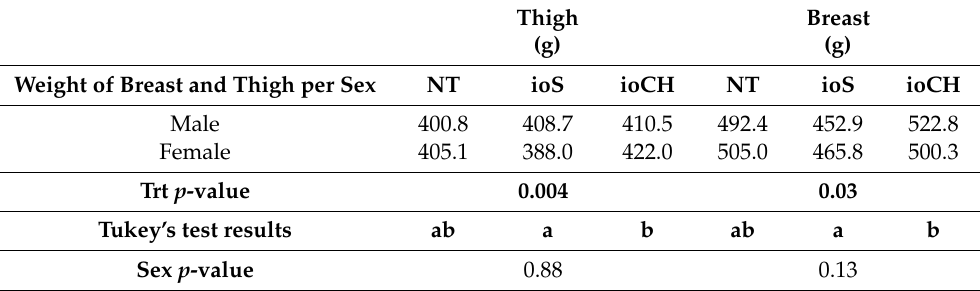
Table 8. Thigh and breast muscle